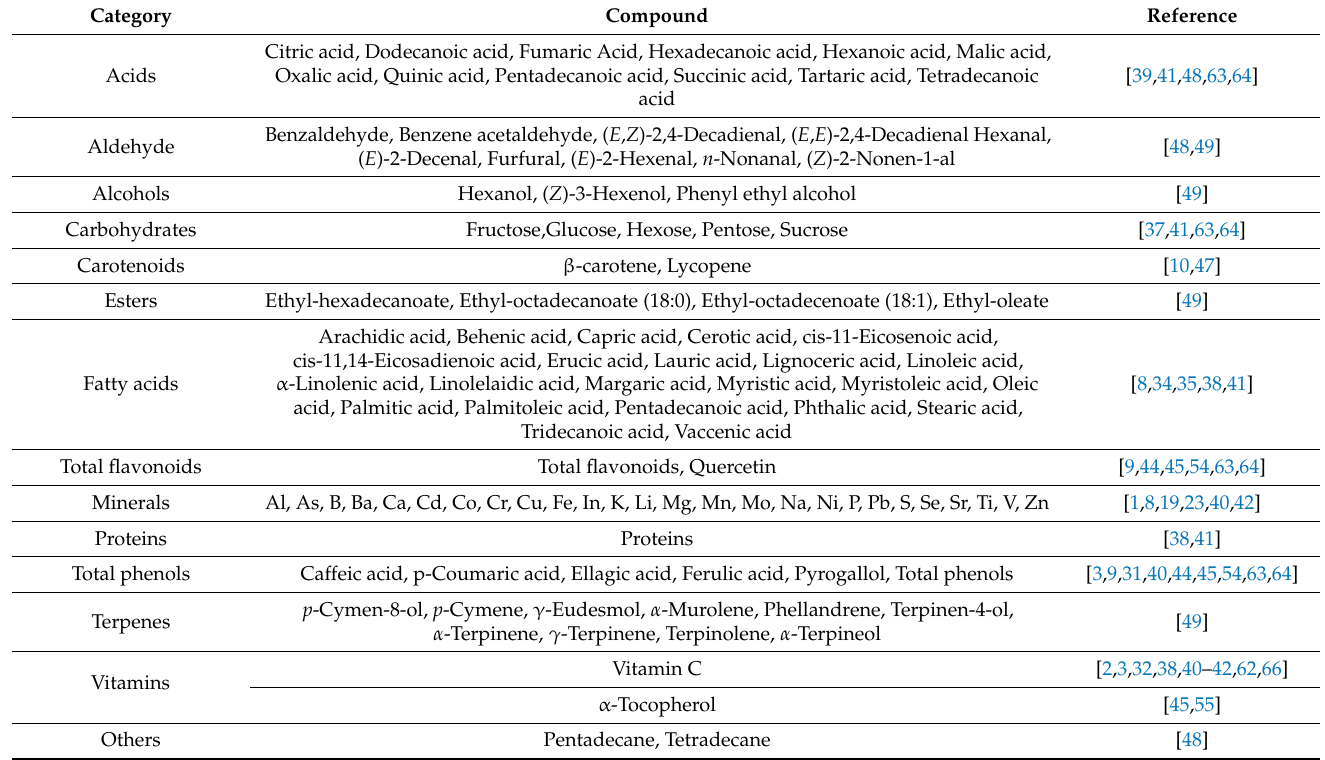
Table 5. Major chemical components of medlar